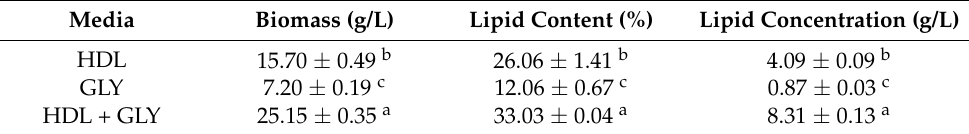
Table 1. Cell dry weight, lipid content, and lipid concentration when culturing R. glutinis TISTR 5159 in hydrolysate (HDL), glycerol (GLY) and hydrolysate mix with glycerol (HDL + GLY) at 30 ◦ C with orbital shaking at 200 rpm for 144